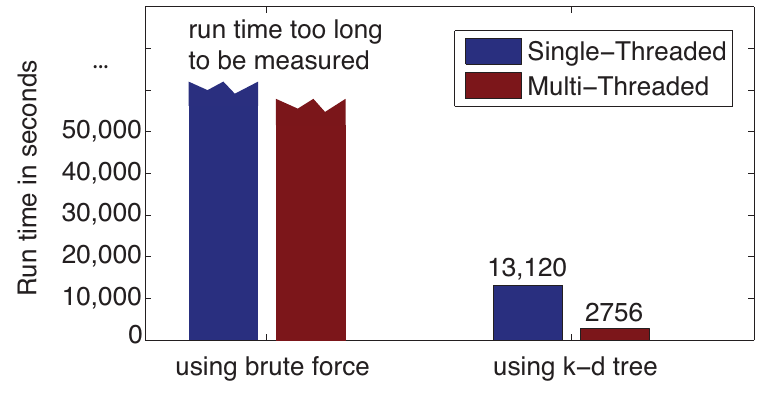
Figure 16. The effect of k-d tree with paralleling programming on IDW run time using the PM data at the census block group 2 : 5